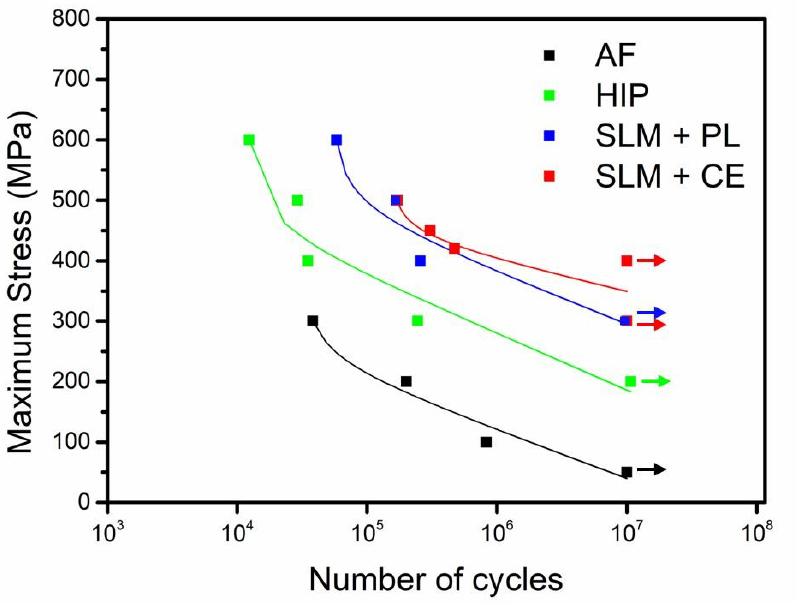
Figure 9. S-N curve of SLMed Ti-6Al-4V alloy in the form of as-fabricated (AF), compared with HIP, Figure 9. S‐N curve of SLMed Ti‐6Al‐4V alloy in the form of as‐fabricated (AF), compared with HIP, HIP and polishing (HIP + PL), and HIP and chemical etching (HIP + HIP and polishing (HIP + PL), and HIP and chemical etching (HIP + CE).